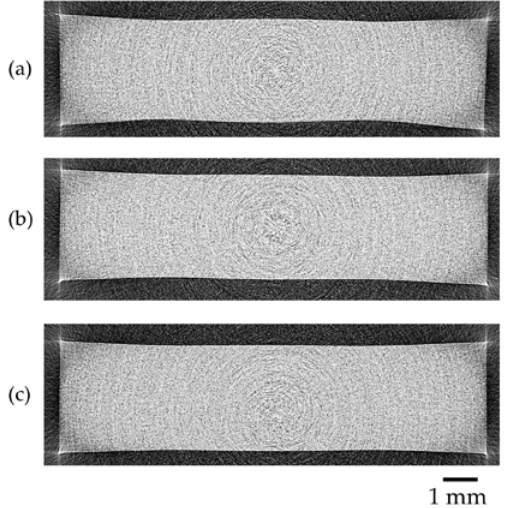
Figure 8. Micro-Computed Tomography (μCT) images of injection-molded samples: ( a ) regular injection-molded sample; ( b ) N 2 sample; and ( c ) CO 2 sample.